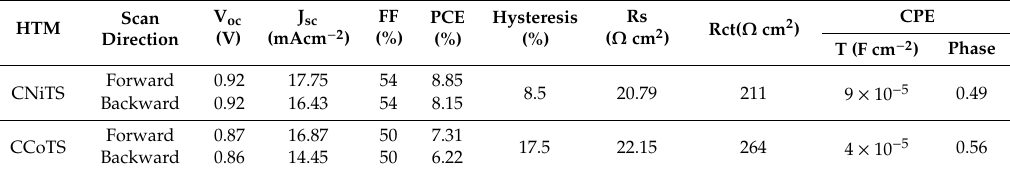
Table 1. Photovoltaic parameters of the CM(Ni, Co)TS-based (100 mg mL − 1 ) PSCs with a 50 mVs − 1 scan